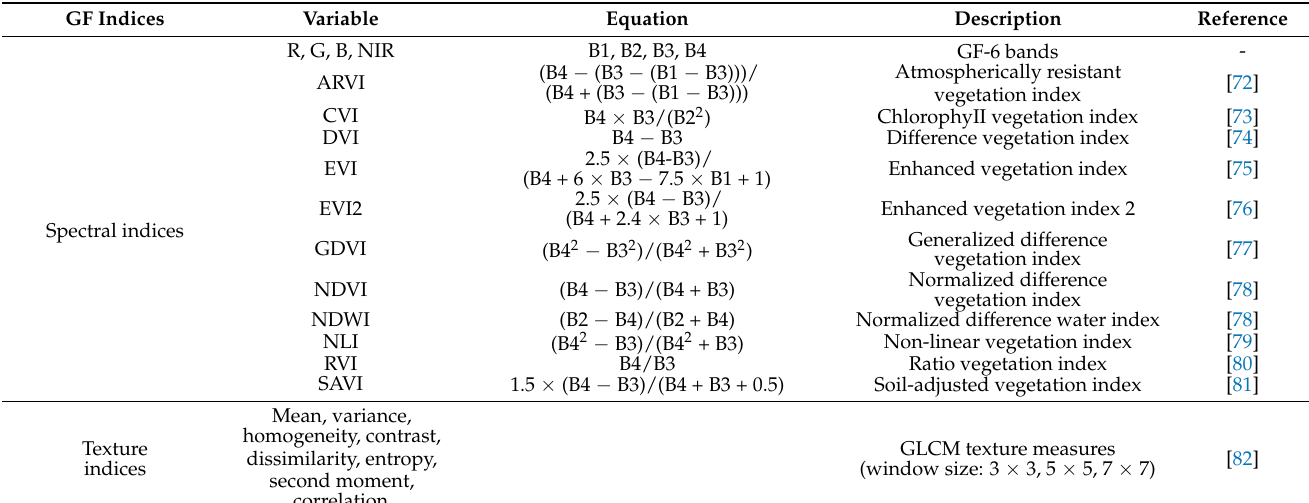
Table 3. A summary of GF metrics derived from GF-6